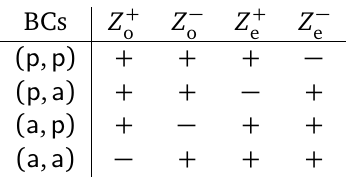
Table 1: Sign of the contributions Z ± according to the combination of periodic ( p ) e / o and antiperiodic ( a ) boundary conditions in parallel and perpendicular